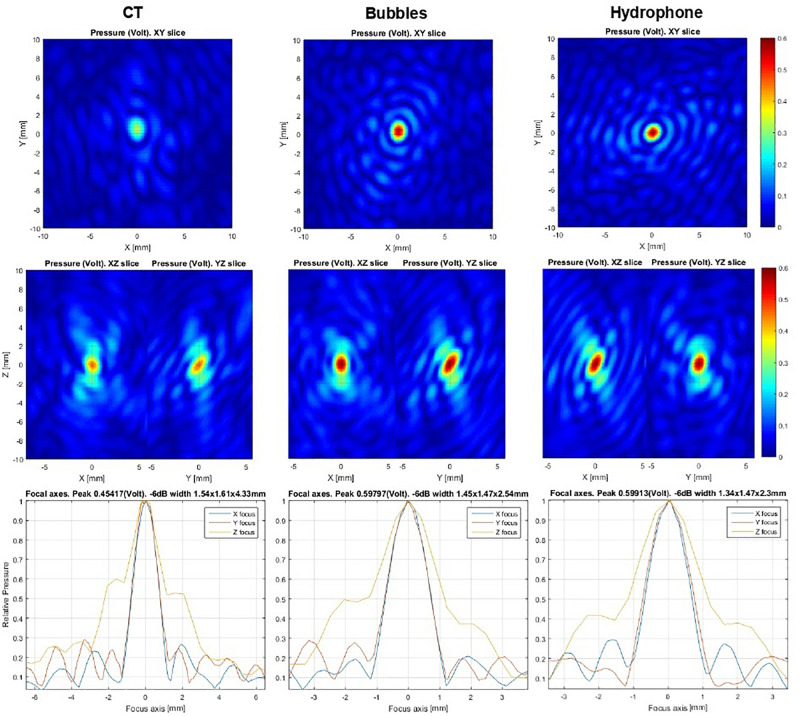
Ex vivo hydrophone focal scans at the 30 mm off-center point in the skull. The left column shows computed tomography-based correction used as an initial guess. The middle column represents microbubble-based correction, while the right column depicts a hydrophone-based result. The same acoustic power was emitted for all scans. Relative peak intensity values can be used as focusing accuracy criteria. Algorithm similarity score: AF/CT = 0.55, AF/hydrophone = 0.85.